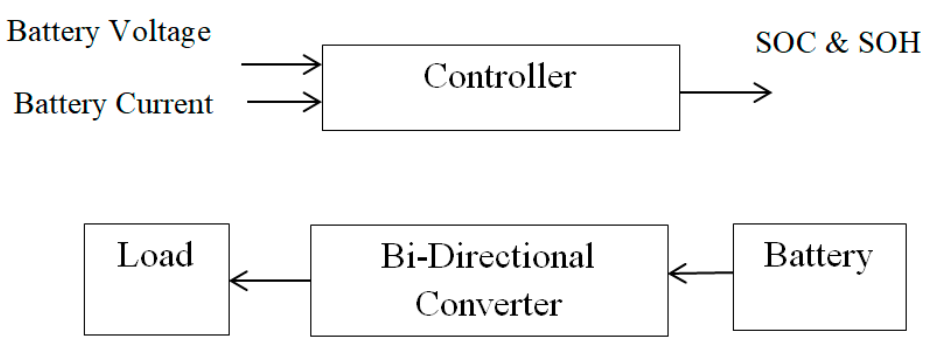
Figure 9. Scheme for which SOH was estimated.